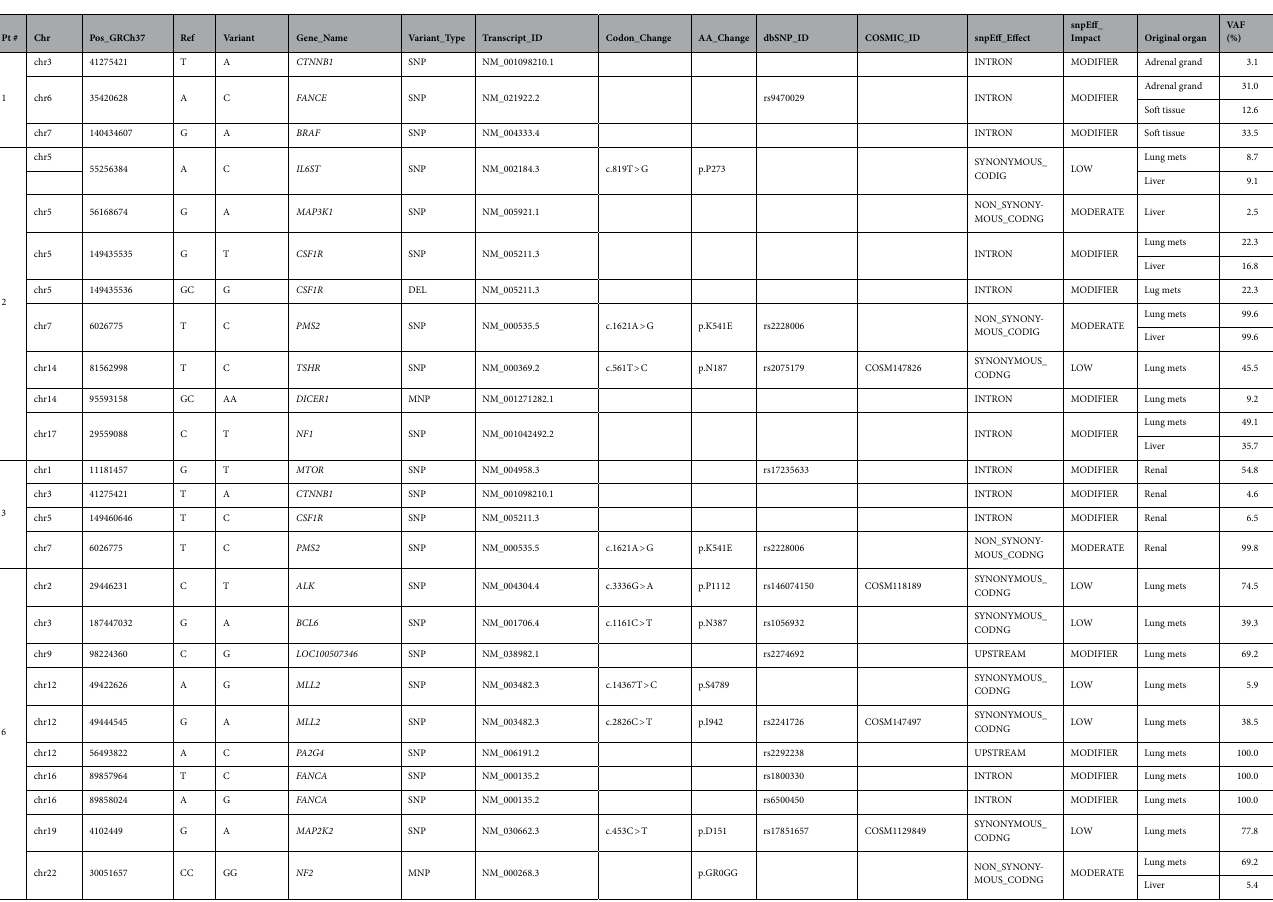
Table 4. The list of gene alterations detected both in cfDNA at diagnosis and in newly metastasized tumor (not detected in primary tumor). Pt patient, chr chromosome, Ref reference, AA amino acid, SNP single nucleotide polymorphism, VAF variant allele frequency, mets metastasis, DEL deletion, MNP manganese